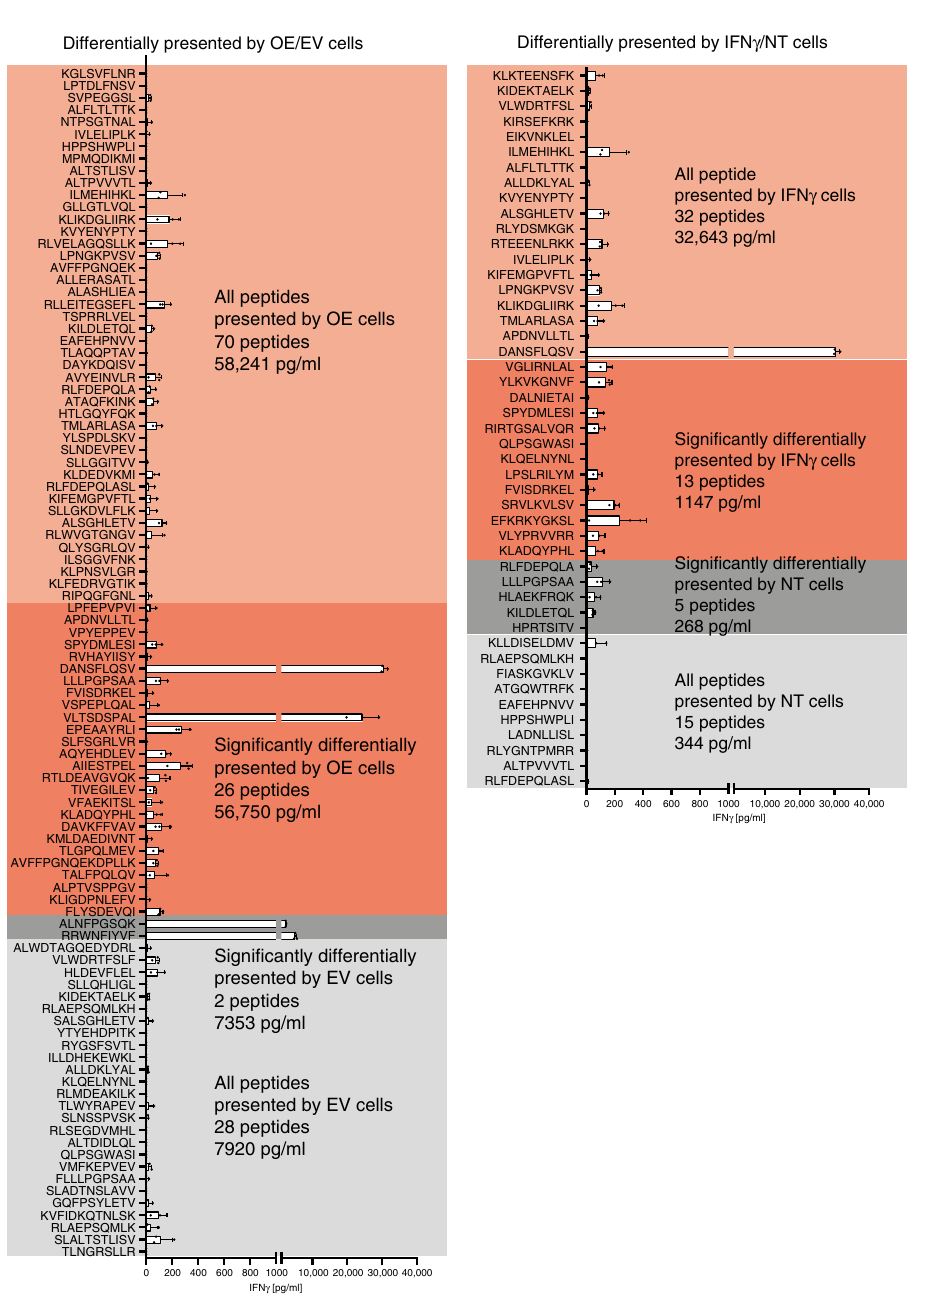
Fig. 4 HLA peptide repertoire of 12T cells with overexpression of immunoproteasome subunits is more immunogenic compared to the control peptide repertoire. All peptides whose fold change in intensity was greater or smaller than one by cells with immunoproteasome overexpression compared to empty vector control ( a ) or cells treated with IFN γ compared to untreated cells ( b ) were tested for their ability to elicit an immune response by the autologous TILs. The reactivity of each peptide was measured from n = 3 biological repeats per each peptide and represented as mean ± SD. The sum reactivity of each group of peptides, and the number of peptides in each group is indicated. Red and gray areas represent all peptides whose fold change intensity was greater or smaller than one by the OE/IFN γ cells and EV/NT cells, respectively (including the signi fi cantly changed peptides). Dark red and dark gray areas represent the peptides that were signi fi cantly differentially presented by the OE/IFN γ cells and EV/NT cells respectively. For each condition the sum reactivity was calculated for all peptides and for the ones that were signi fi cantly differentially